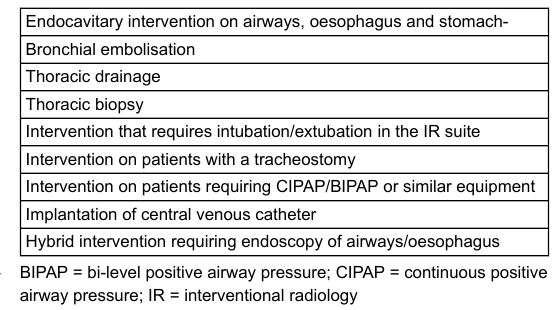
Table 1: Interventions on COVID-19 patients presenting a high risk for transmission to the IR